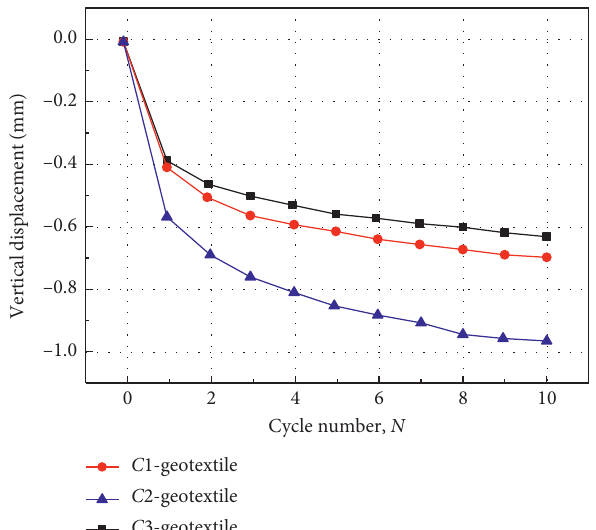
Figure 5: Relationships between interface vertical displacement and number of cycles with different sand particle-size